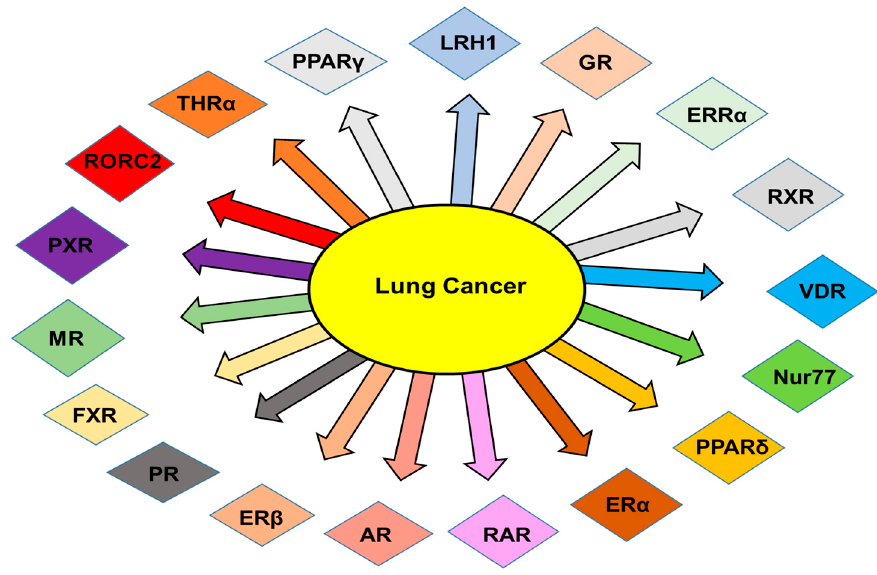
Figure 2. Different types of NRs implicated in lung cancer.